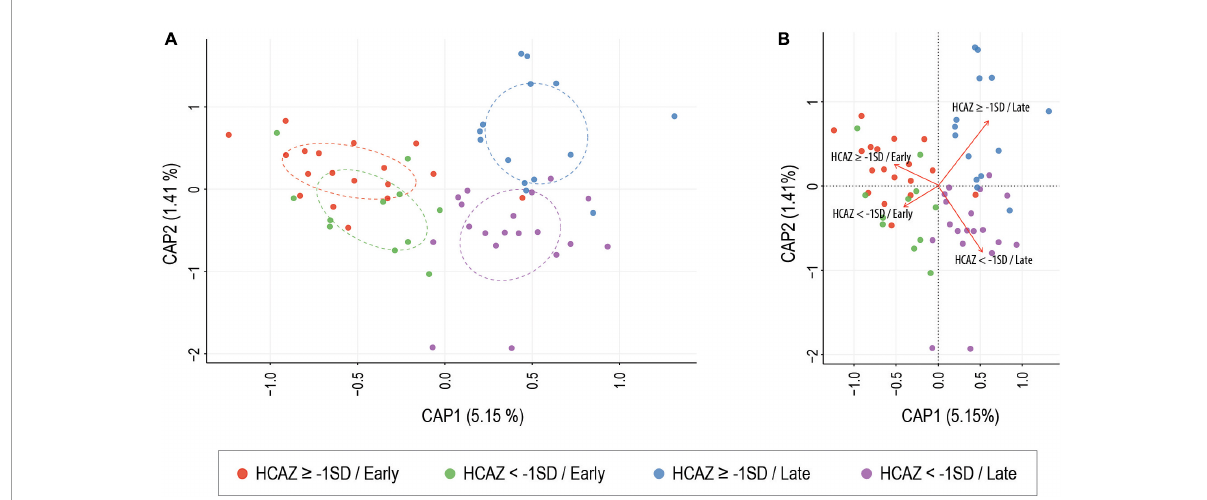
FIGURE4 Constrained ordination (CAP) analysis of milk microbial communities present between head-circumference-for-age-z-score (HCAZ ≥ − 1 SD) and HCAZ < − 1 SD at early and late lactation stages. ANOVA-like permutation test showed significant differences between groups at both stages of lactation ( p = 0.003). (A) Circles represent sample density relative to each group. (B) CAP distance biplot showing individual samples colored by groups and vectors (in red) corresponding to the variable loadings (i.e., variable contribution). The black crosses represent the geometric centre of each group.